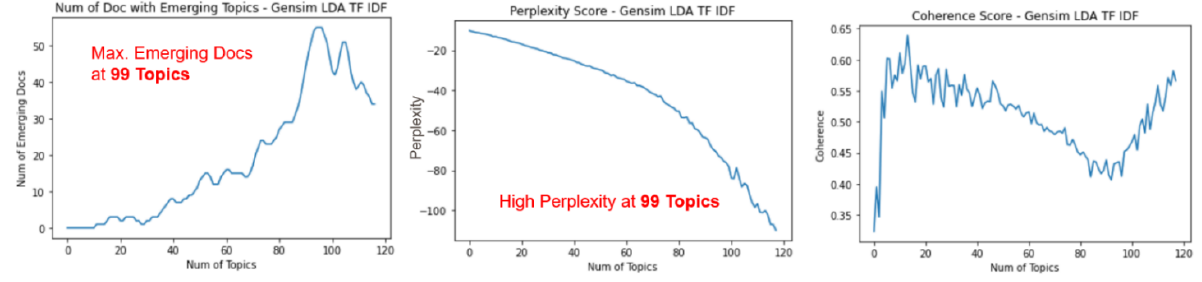
Figure 13. Emerging topic detection filtered-LDA Framework #2.